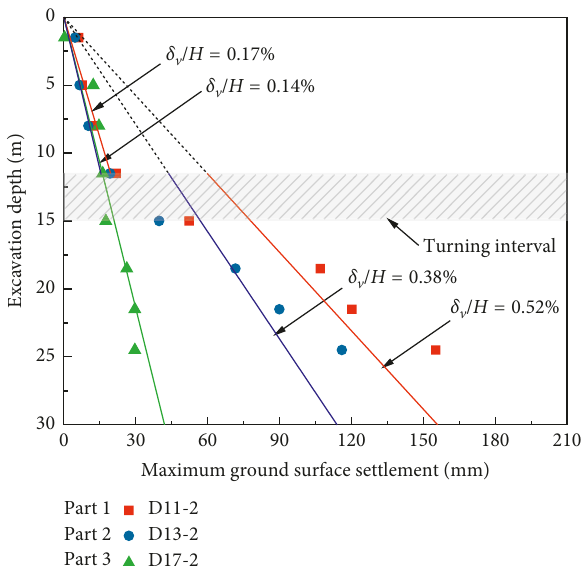
Figure 14: Ratio of the maximum surface settlement to the excavation depth ( δ